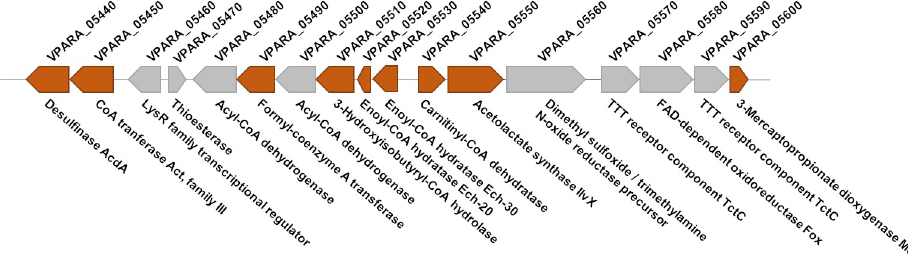
Fig 3. Gene cluster relevant for TDP degradation as indicated by proteome analysis, comprising mdo , act and acdA . Proteins with high abundance during cultivation with TDP identified by proteome analysis are marked in